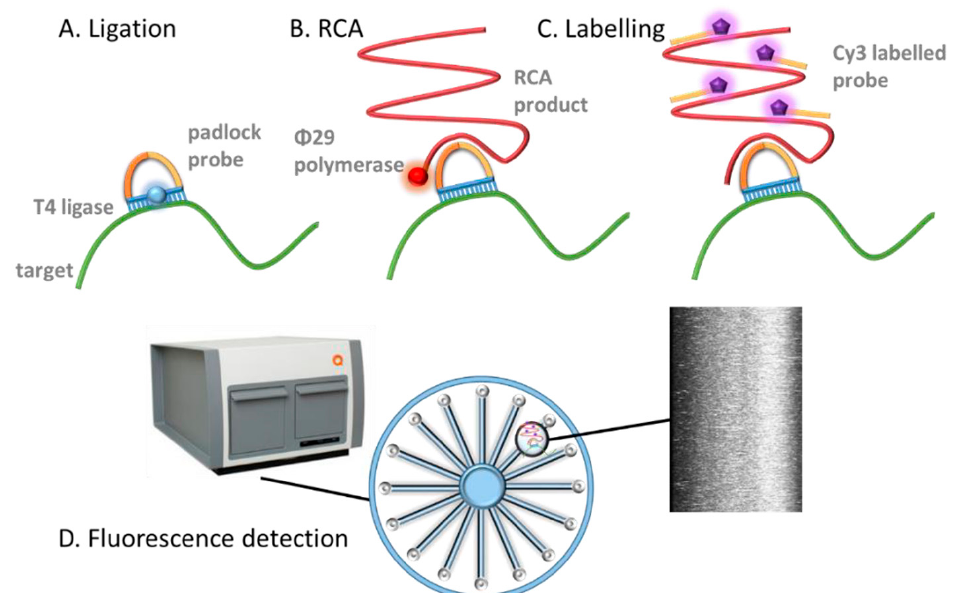
Figure 2. Schematic representation of the rolling circle amplification readout based on fluorescence. ( A ) Padlock probe is hybridized on the bacterial DNA target, followed by ligation; ( B ) Rolling circle amplification ( C ) Hybridization with the Cy3 readout probe acting as fluorescent reporter; ( D ) Detection with Aquila 400 detection equipment.